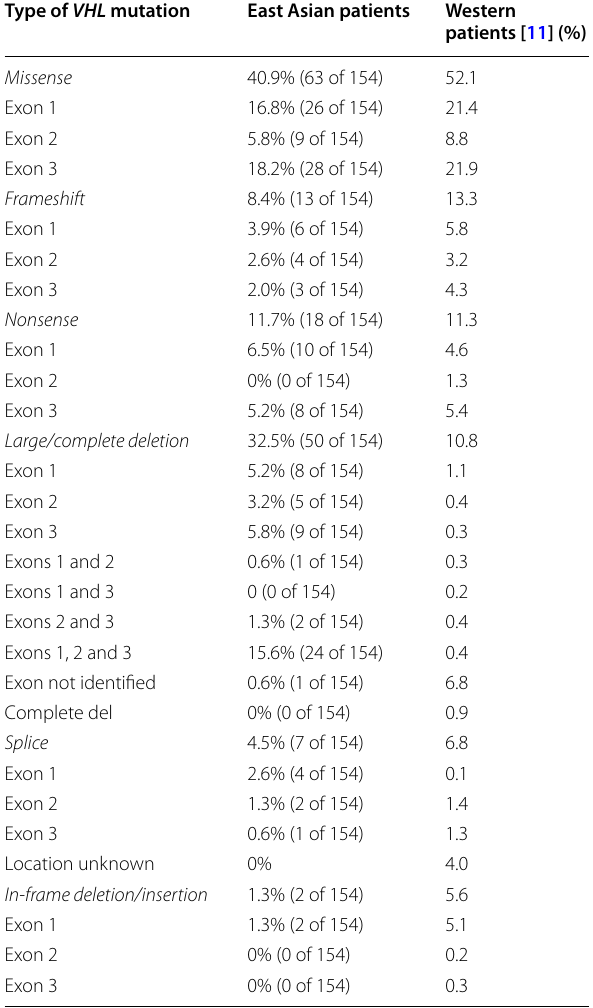
Table 1 Summary of the distribution of genetic mutations in the von Hippel–Lindau ( VHL ) gene between East Asian and Western patient